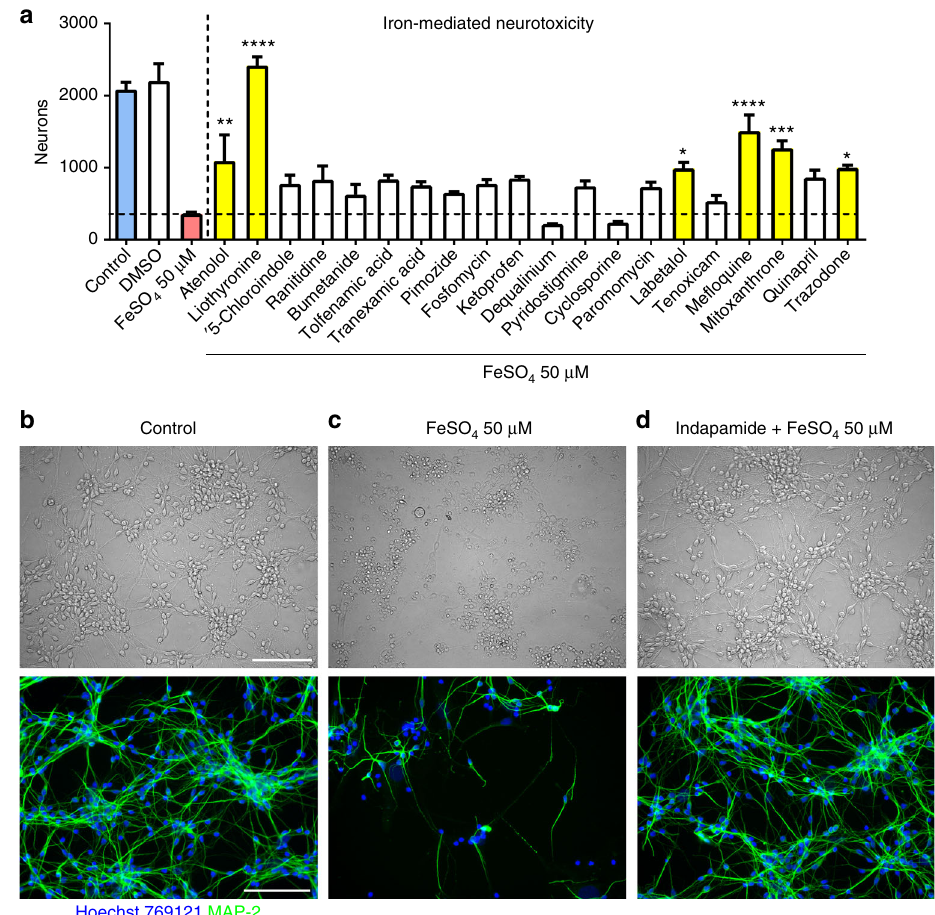
Fig. 1 Screening of generic compounds to prevent iron-mediated neurotoxicity. Shown is an example of a screening of drugs to identify those that prevent iron-mediated neurotoxicity to human neurons. Neurons were pretreated with drugs at a concentration of 10 µ M, followed by a challenge with 25 or 50 µ M FeSO 4 after 1 h. In this experiment, several compounds (yellow bars) prevented against iron-mediated neurotoxicity as determined by the number of survival neurons in automated counts after 24 h ( a ). Values in a are mean ± SEM of n = 4 wells per condition. One-way analysis of variance (ANOVA) with Bonferroni post hoc analysis vs. iron: * p < 0.05; ** p < 0.01; *** p < 0.001; **** p < 0.0001. b – d Representative images show the untreated control and iron- treated neurons, as well as the prevention of neurotoxicity by indapamide (top: bright fi eld; bottom: fl uorescence microscopy). Neurons were detected by anti-MAP-2 antibody. The scale bars depict 100 µ